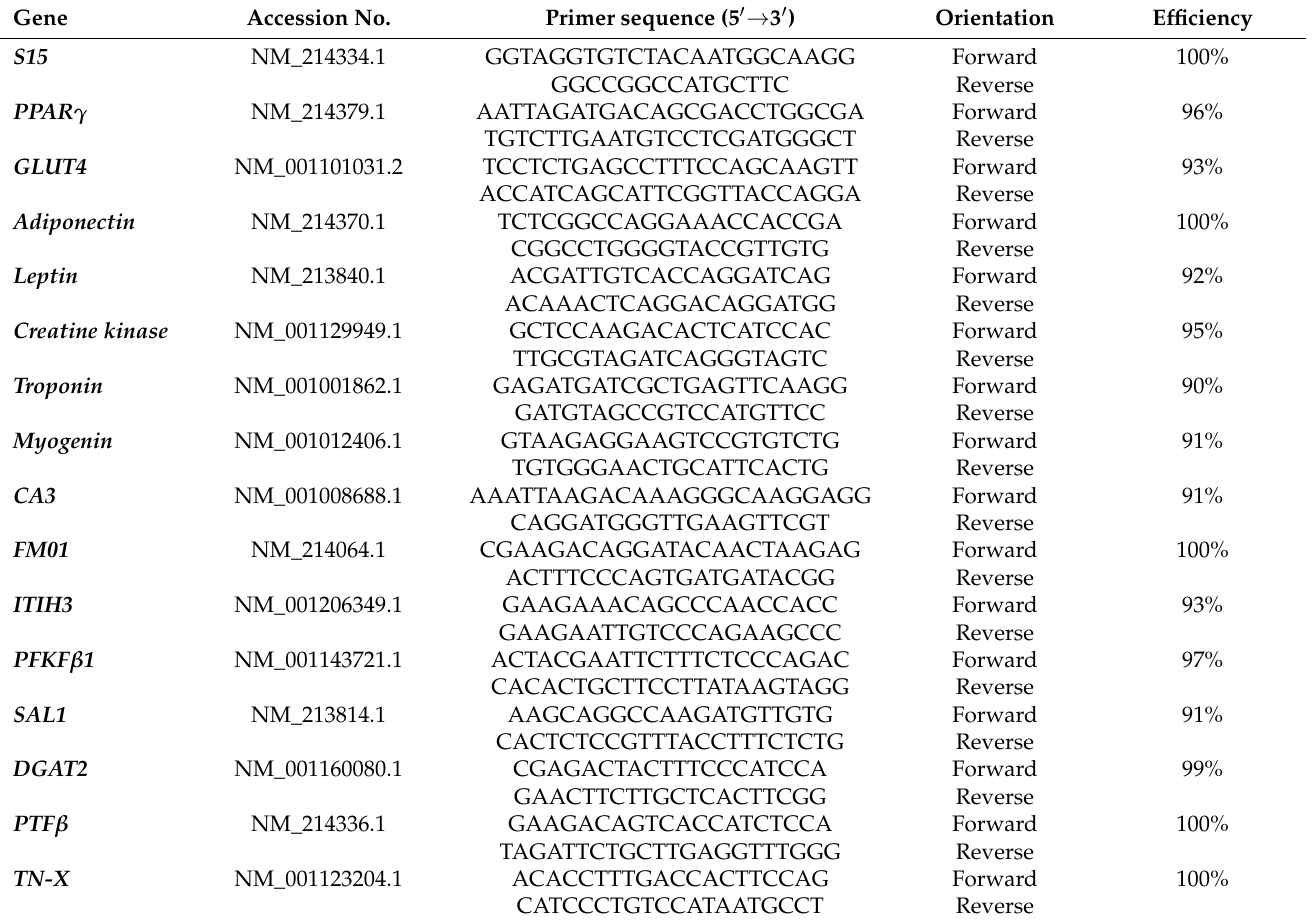
Table 1. Oligonucleotide polymerase chain reaction